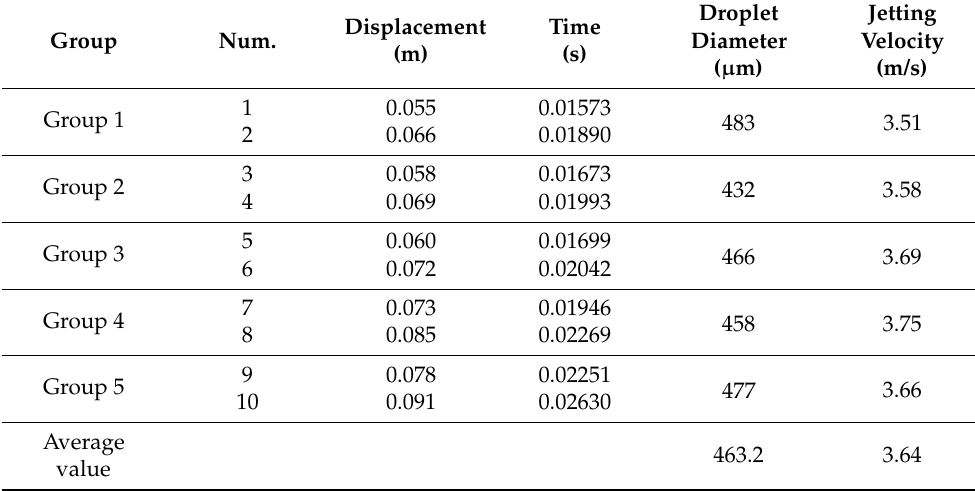
Figure 10. Displacement of the second group of experiments at different moments. ( a ) initial state of the droplet, ( b ) the displacement of the 16.73 ms, ( c ) the displacement of the droplet at 19.93 ms.